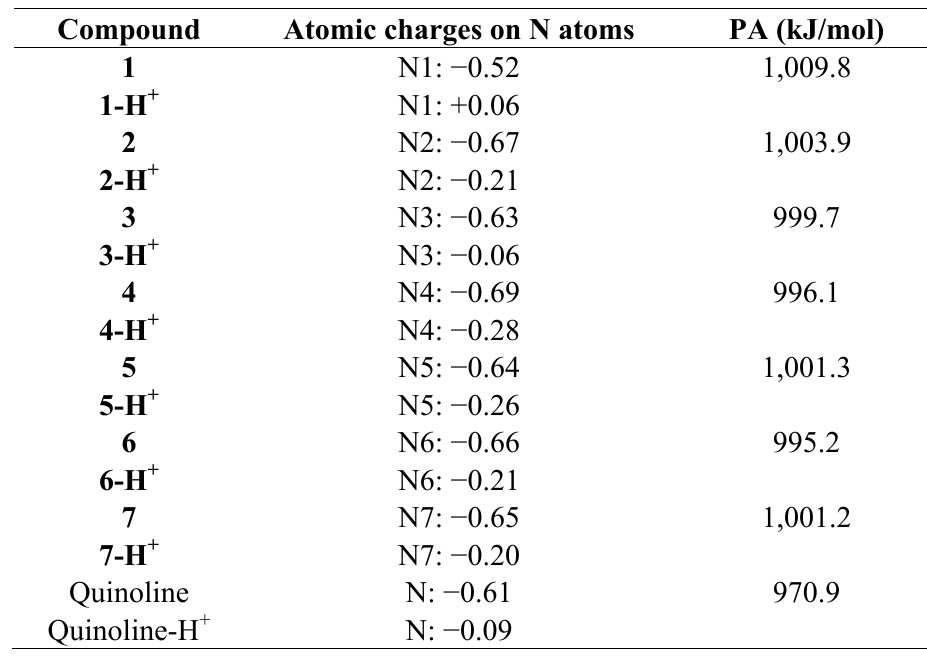
Figure 2. Computed structure of 1-aza[5]helicene with C14-N1 interatomic